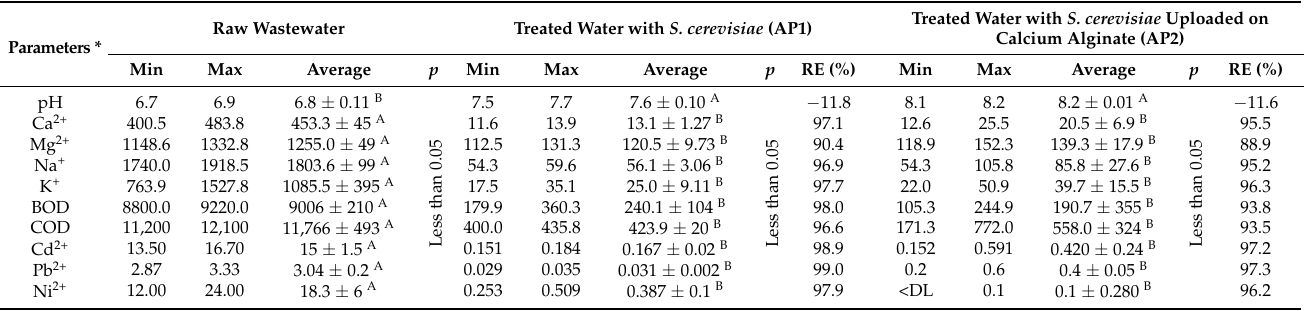
Table 7. Water quality parameters of raw wastewater, and treated water after the application of S. cerevisiae , p -value, and their removal efficiency (RE%). (n = 3